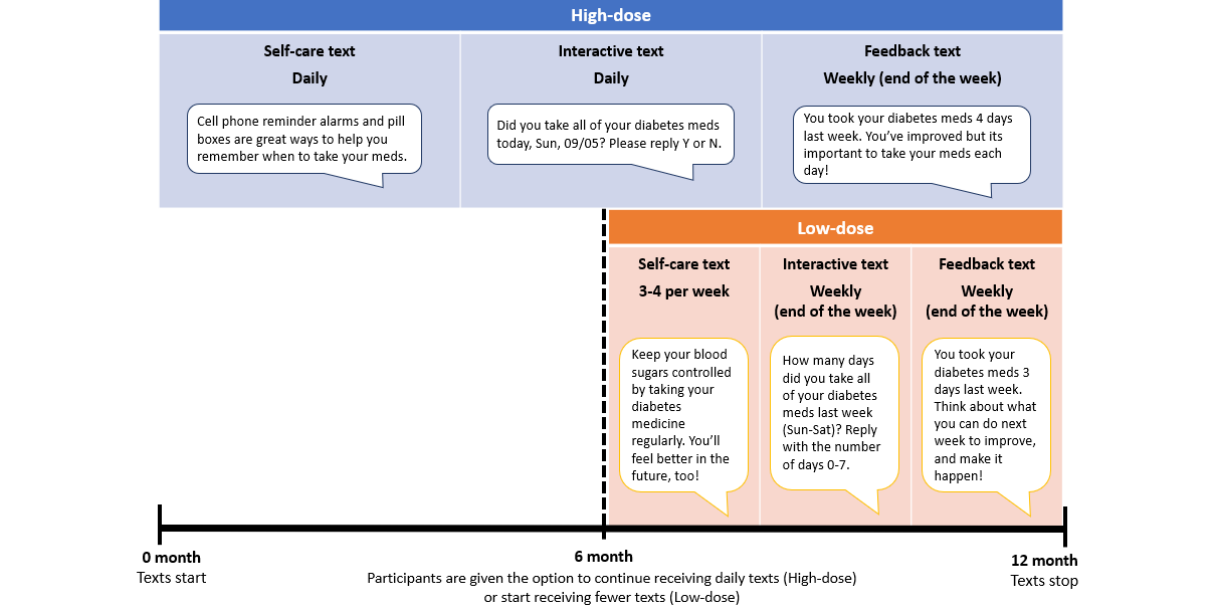
Figure 1. High-dose and low-dose REACH text message frequencies and content examples. REACH: Rapid Education/Encouragement And Communications for